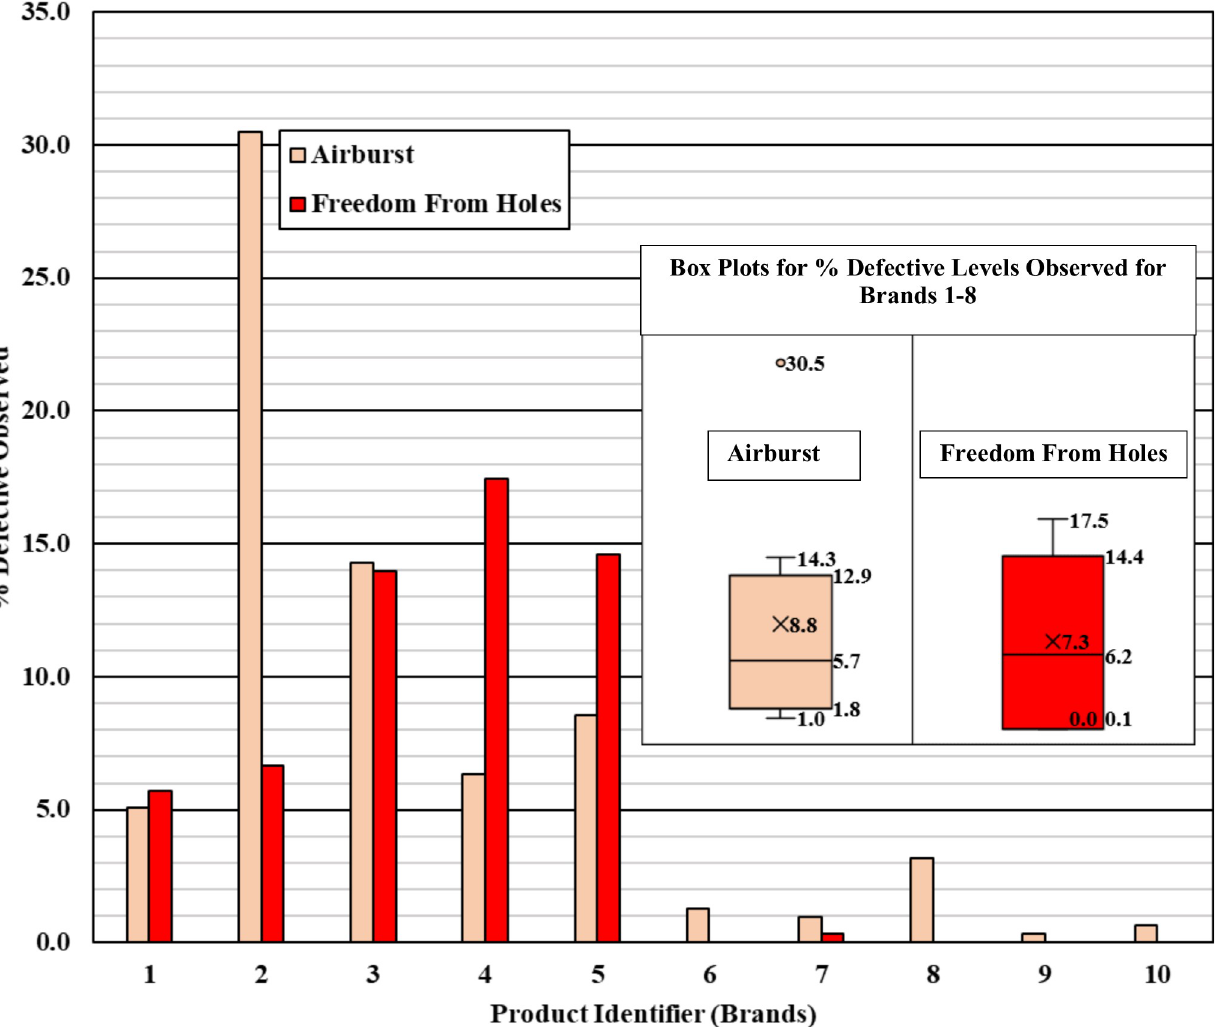
Fig 1. Percent defective (based on number of failures found relative to the number tested as shown in Table 1) observed for both airburst and freedom from holes testing for each sampled